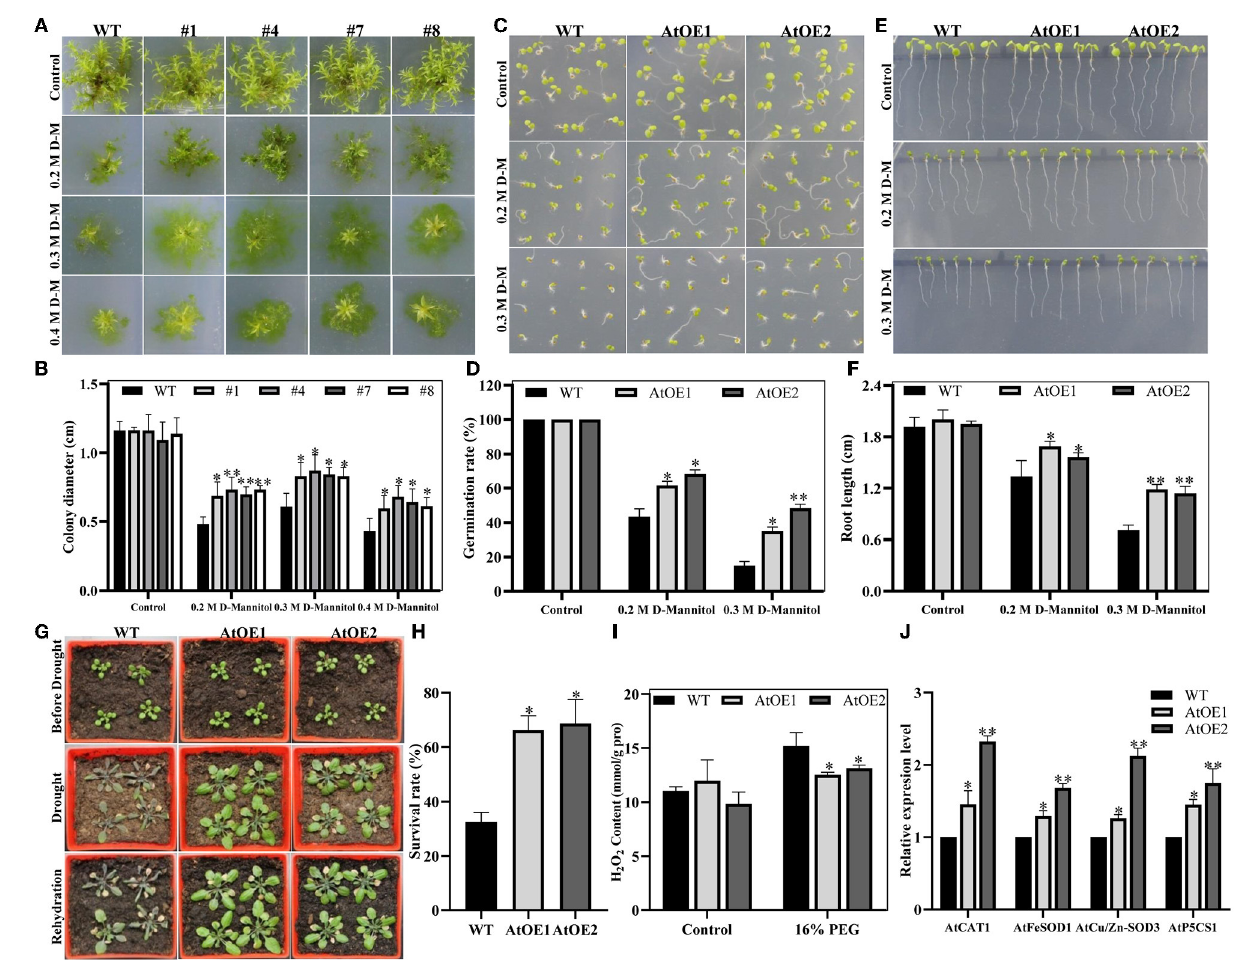
FIGURE 6 | Pn2-ODD1 increased the resistance to drought stress in transgenic P. patens and Arabidopsis . (A) The diameter of transgenic P. patens gametophytes was markedly larger than that of the WT plants under drought stress conditions. (B) Statistical analysis of gametophyte size as shown in (A) . (C,E) Expressed- Pn2-ODD1 Arabidopsis exhibited higher germination rates and longer root length compared with WT plants under osmosis stress. (D,F) Statistical analysis of the seed germination rates and root length as shown in (C,E) . (G) Three-week-old Arabidopsis seedlings grown in soil were withheld water for 21 days, and then rewatered for 3 days. (H) Statistical analysis of the survival rate, as shown in G . (I) H 2 O 2 content in Arabidopsis under 16% PEG treatment. (J) Gene expression levels of ROS-scavenging related genes in Arabidopsis analyzed by qRT-PCR. Asterisk (*) indicates a significant difference between the WT plants and AtOE lines (Student’s t -test, * P < 0.05, ** P <